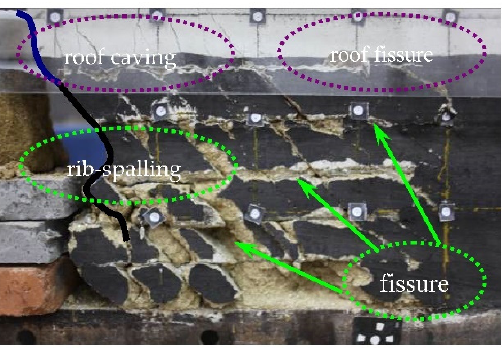
Figure 12. Development of joint and instability form the coal wall rib-spalling ( α = 120 ◦ ).